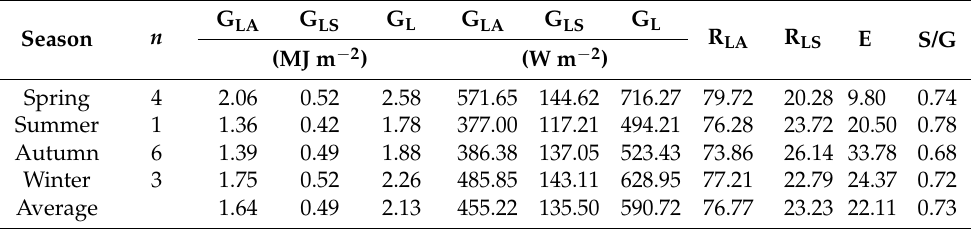
Table 2. Seasonal mean values of losses of global solar irradiance (MJ m − 2 ) and radiation (W m − 2 ) caused by absorbing and scattering substances (G LA and G LS ), total loss (G L = G LA + G LS ), and their contributions to total loss (R LA and R LS , %), seasonal mean values of monthly mean water vapor pressure (E, hPa), and S/G for S/G < 0.80 conditions. n is the number of months in each season for which data are